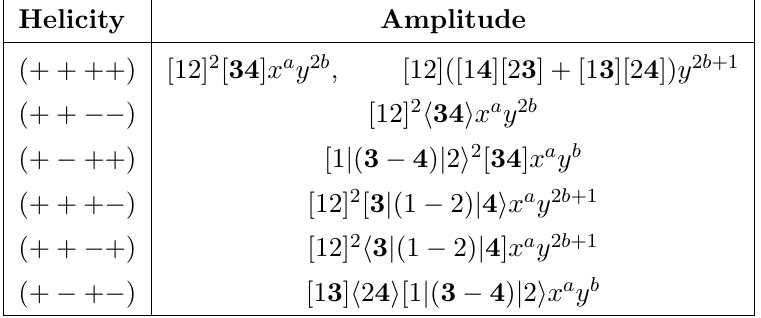
Table 1 . The amplitude basis for electromagnetic finite-size effects. The helicity labels are ordered as ( γ 1 γ 2 ψ 3 ψ 4 ) . The three first rows are the amplitude basis for odd mass dimensions, while the three last rows are for even mass dimensions. Here a and b take integer values from 0 to ∞ . The amplitudes for opposite helicities can be obtained by exchanging angle and square